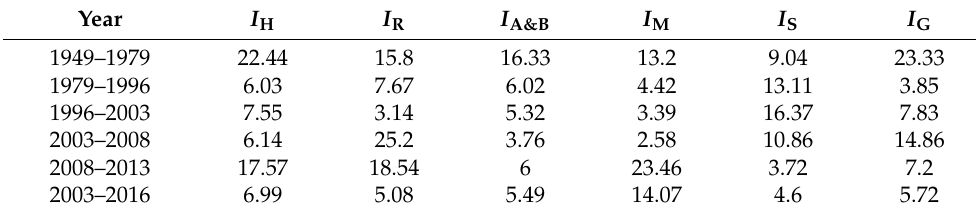
Table 2. Results of urban land expansion intensity.